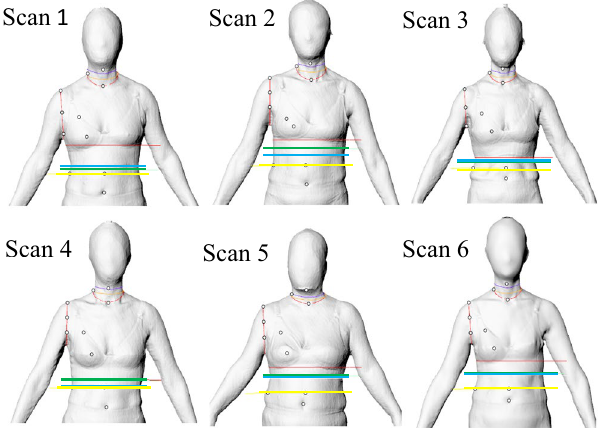
Fig. 8 Results of comparison of waist positions extracted based on four definitions of waist height